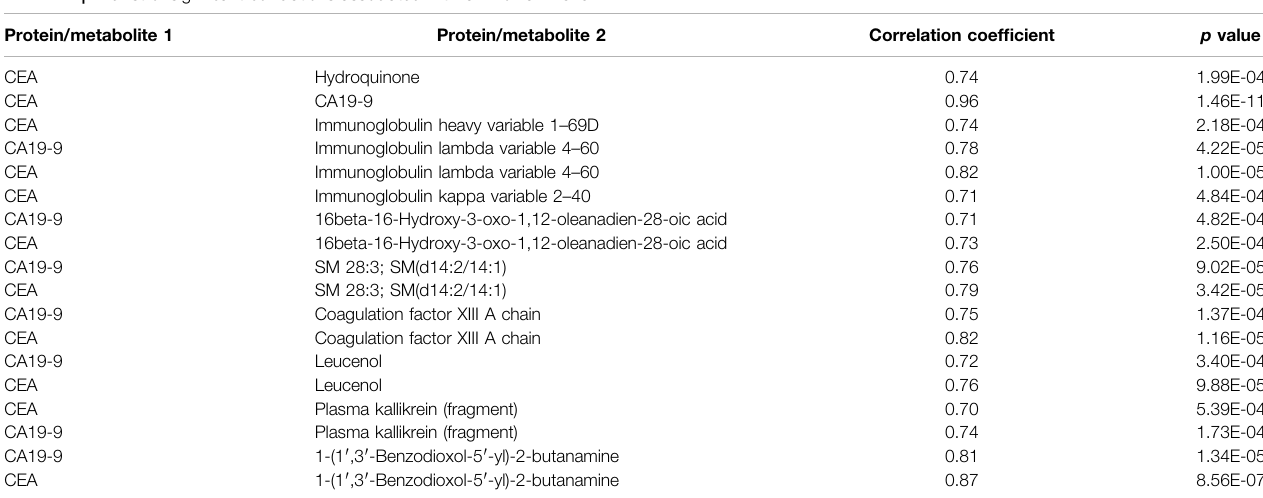
TABLE 2 | The list of signi fi cant correlations associated with CEA or CA 19 – 9. Protein/metabolite 1 Protein/metabolite 2 Correlation coef fi cient p